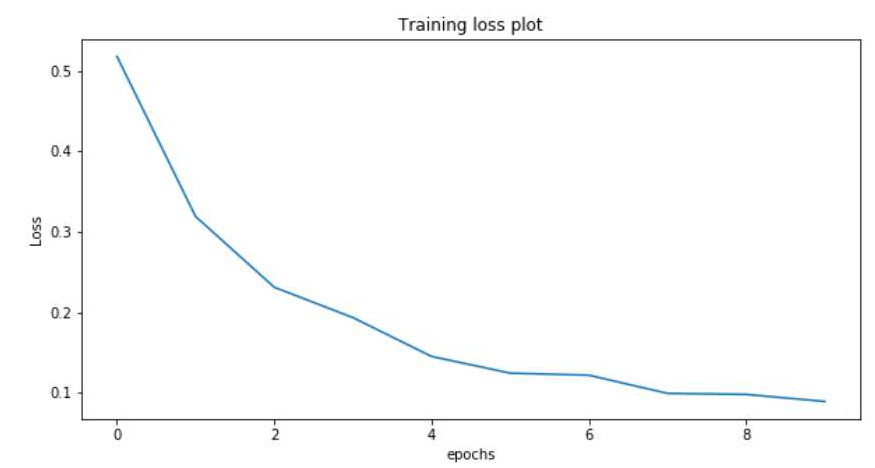
Figure 10. The change of loss values vs. numbers of epochs during the